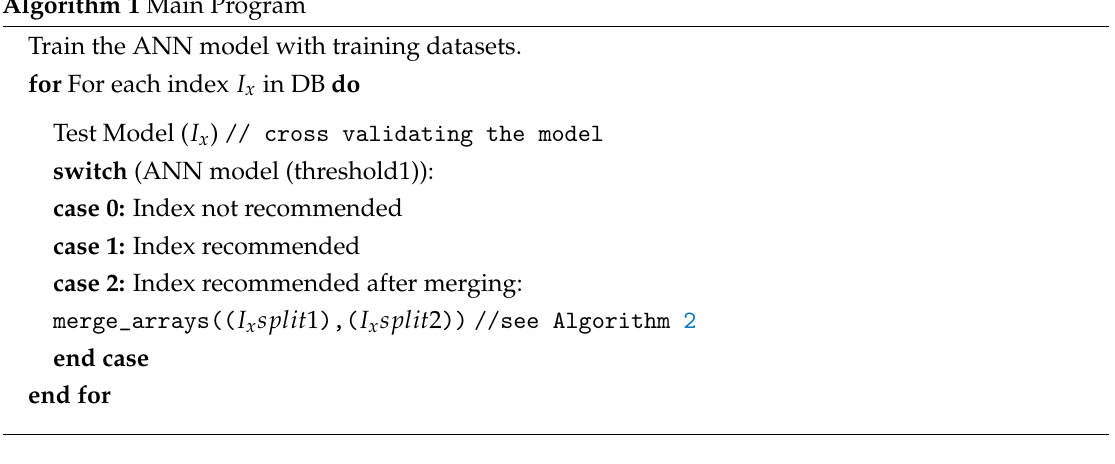
Algorithm 1 Main Program